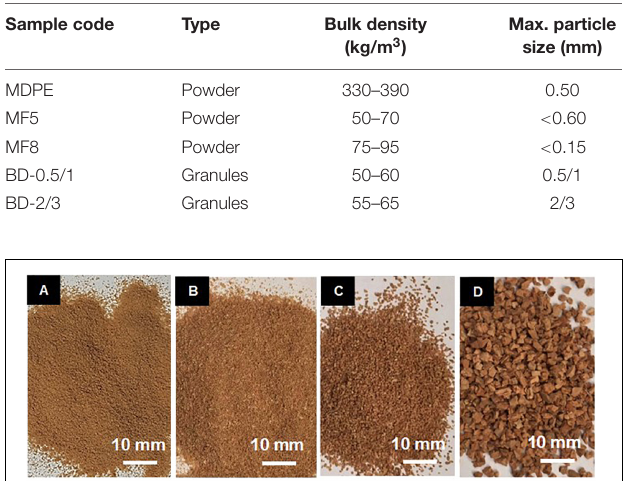
TABLE 1 | Bulk density and maximum particle size of MDPE and cork powders.